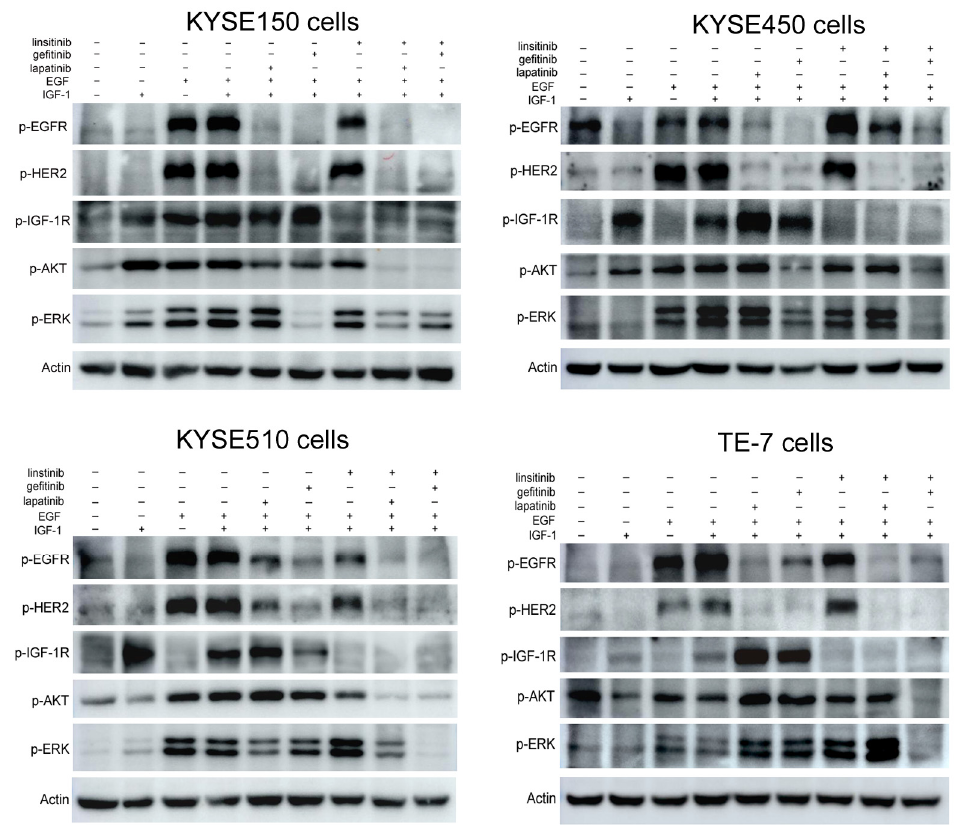
Figure 5. The effects of lapatinib, gefitinib, and linsitinib alone or in combination on the EGFR/HER2 and IGF-1R signaling. Four ESCC cells were serum-starved, treated with single or combined drugs, and stimulated with IGF-1, EGF, or both for 30 min. The phosphorylation of EGFR, HER2, IGF-1R, AKT, and p42/44MAPK (ERK) levels was detected by western blot analysis. β -actin was used as the loading